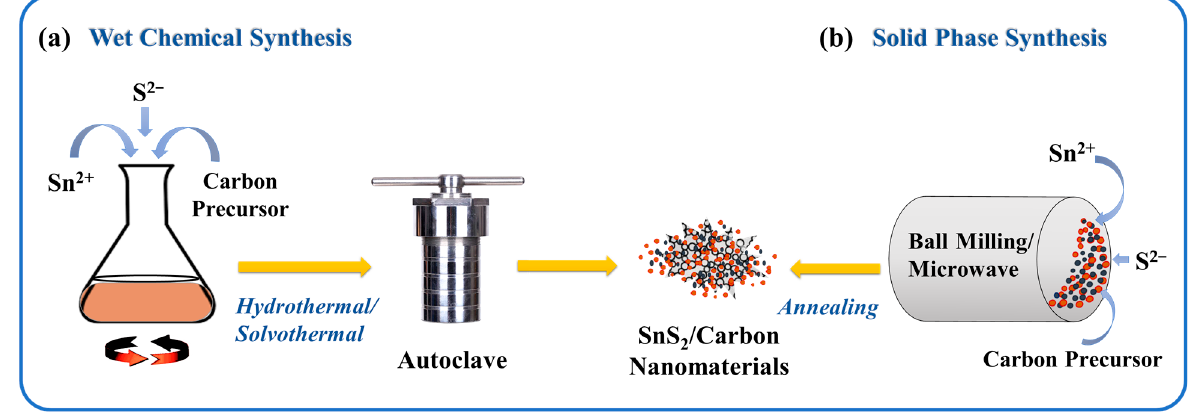
Figure 3. ( a )Schematic illustration of wet chemical synthesis and ( b ) solid-state synthesis route of SnS 2 and SnS 2 /Carbon nanomaterials. Table 1. Comparison of the various SnS 2 /Carbon nanomaterials achieved through wet and solid-state synthesis approaches and their applications.